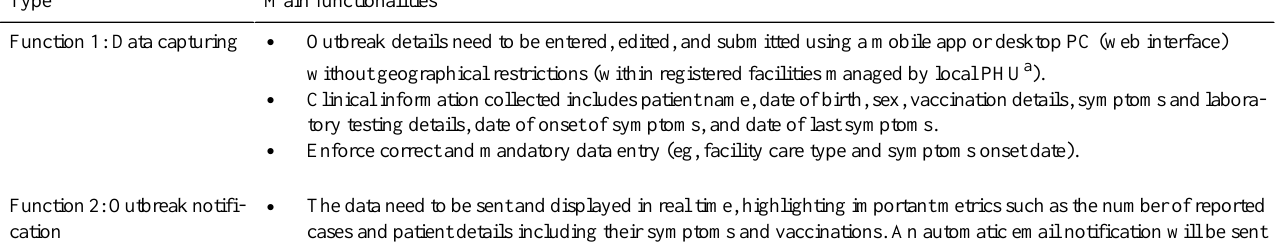
Table 5. The description of the main functionalities of our prototype. Main functionalitiesType